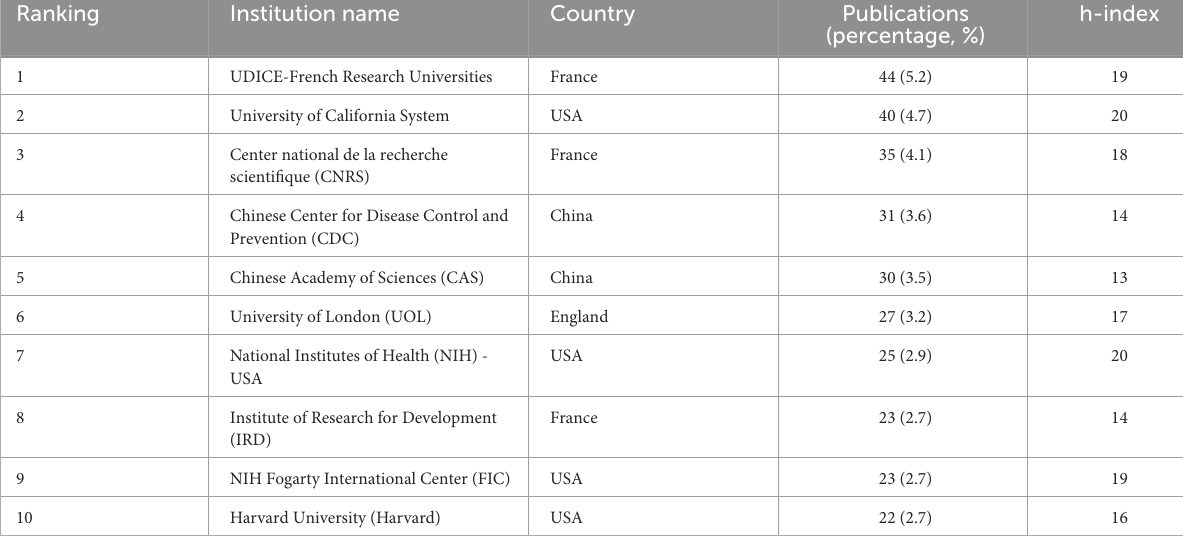
TABLE 5 Top 10 institutions with the most